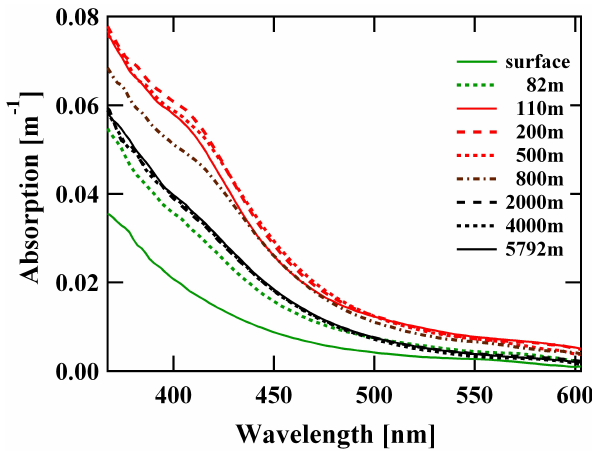
Fig. 2. Light absorption of CDOM in the tropical Atlantic Ocean (12 ◦ S, 2 ◦ W) in November 2005 (ANT-XXIII/1) as a function of wavelength, given for water depths between the surface and